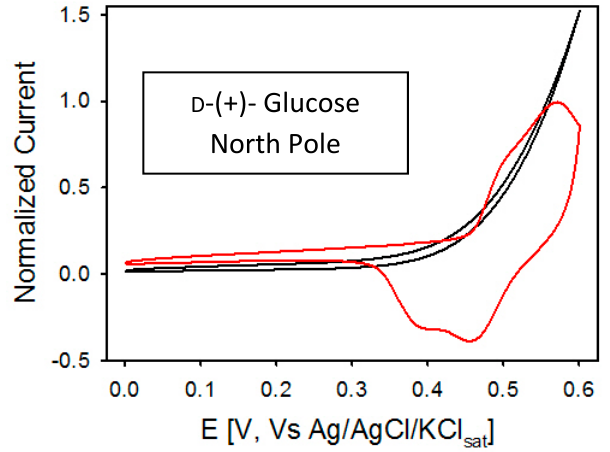
Figure 4. Normalized cyclic voltammetry curves recorded with electrodeposited Ni on the North pole of the magnet. Red curve : KOH 0.1 M aqueous solution. Black curve : 0.1 M of d -( + )-Glucose in KOH 0.1 M aqueous solution. 50 mV / s potential scan rate, a Pt as CE, Ag / AgCl / KCl sat as RE.